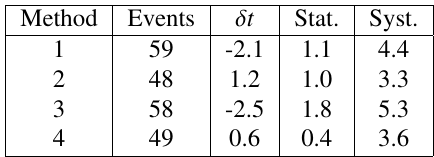
Table 3. Separate results for ν + ¯ ν for each of the four methods reported in the text. All reported time values are in